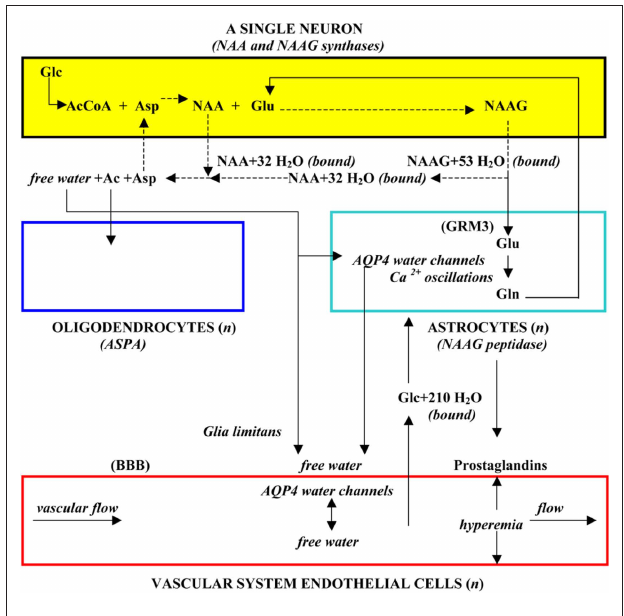
Figure 2 | The structural unit of the brain, a single neuron plus variable numbers of other cells in a four-cell operating system domain (from Baslow, 2010a).Figure 1 | The brain’s NAA–NAAg tri-cellular metabolic